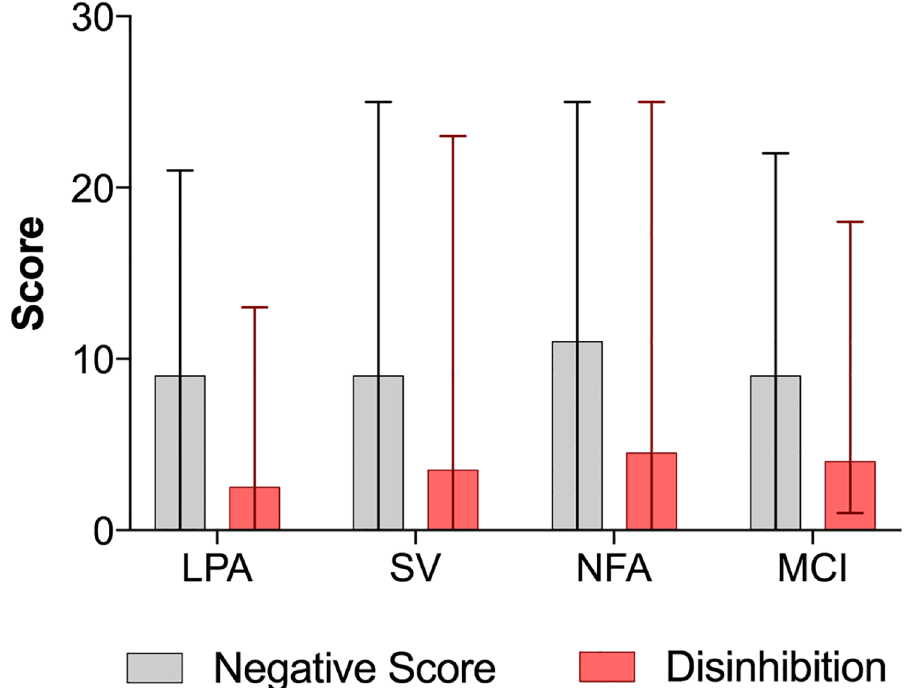
Fig 1. Medians and ranges for modified FBI negative behavior and disinhibition scores for PPA subtypes and MCI. lvPPA, logopenicprimary progressive aphasia; nfaPPA, nonfluentagrammatic primary progressive aphasia; svPPA semanticvariant primary progressive aphasia; MCI, mild cognitiveimpairment.